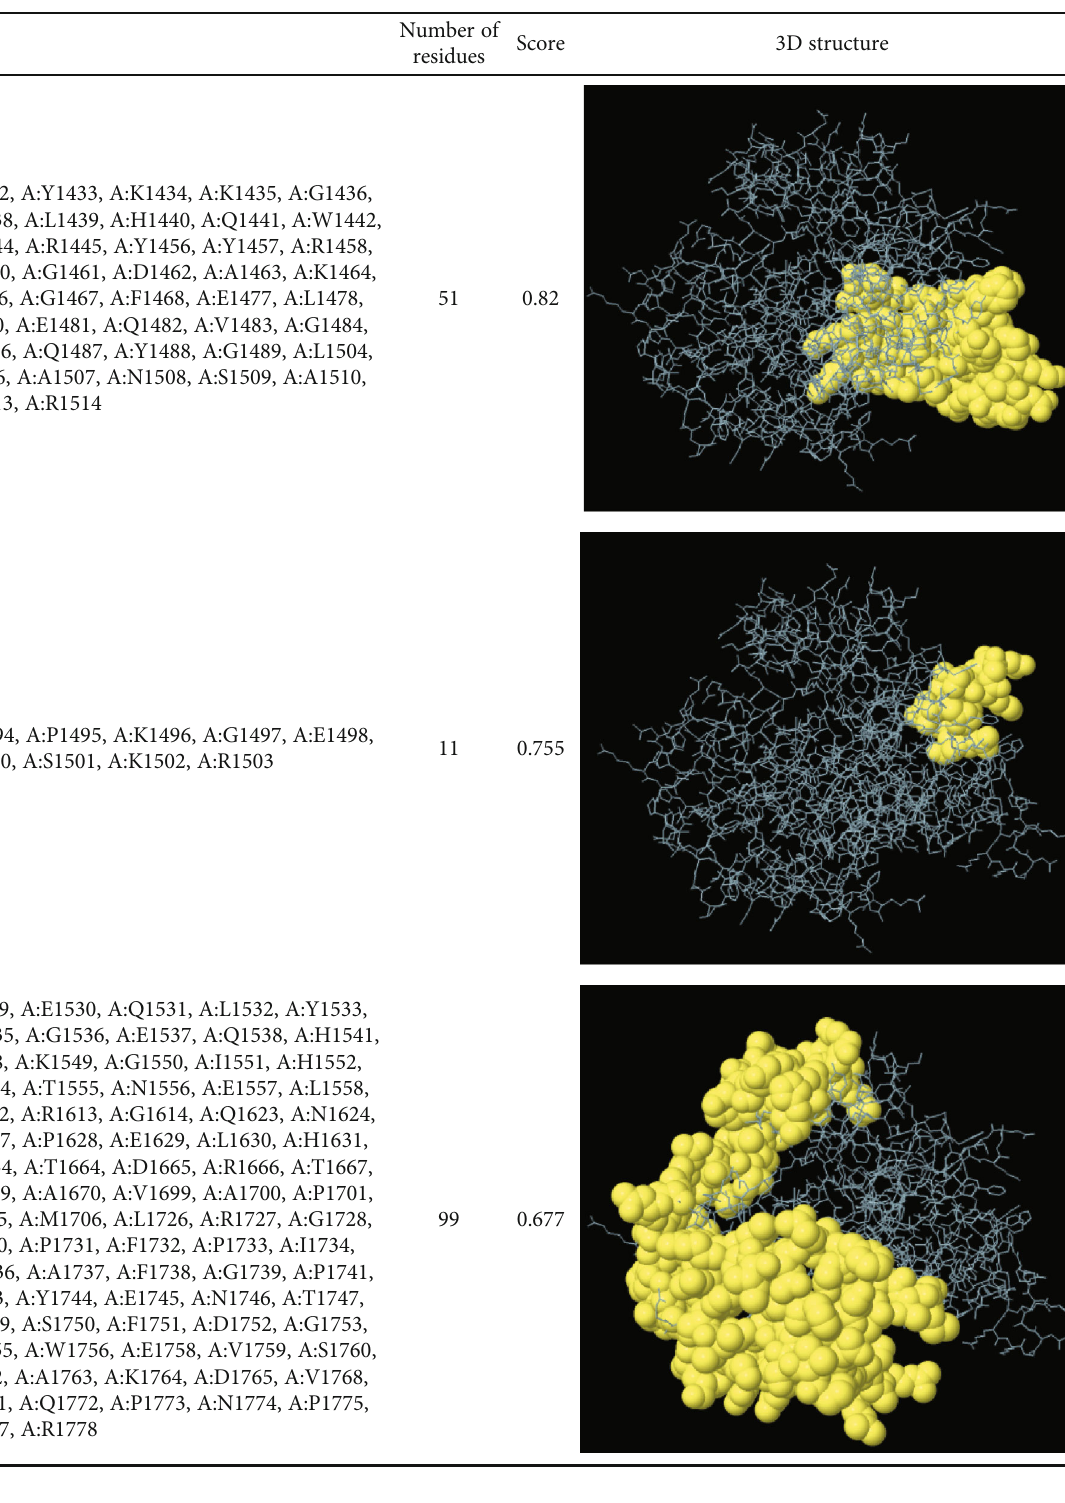
Table 4: Conformational B-cell epitopes of CDPK7 protein predicted by the ElliPro server. Residues